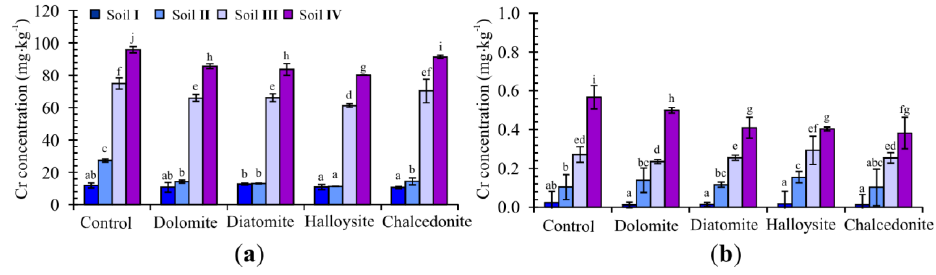
Figure 8. Total ( a ) and CaCl 2 -extractable ( b ) Cr fractions in soil with different soil treatments (mean ± SD, n = 3). Values in columns marked with the same letter do not differ significantly (Duncan test, p >